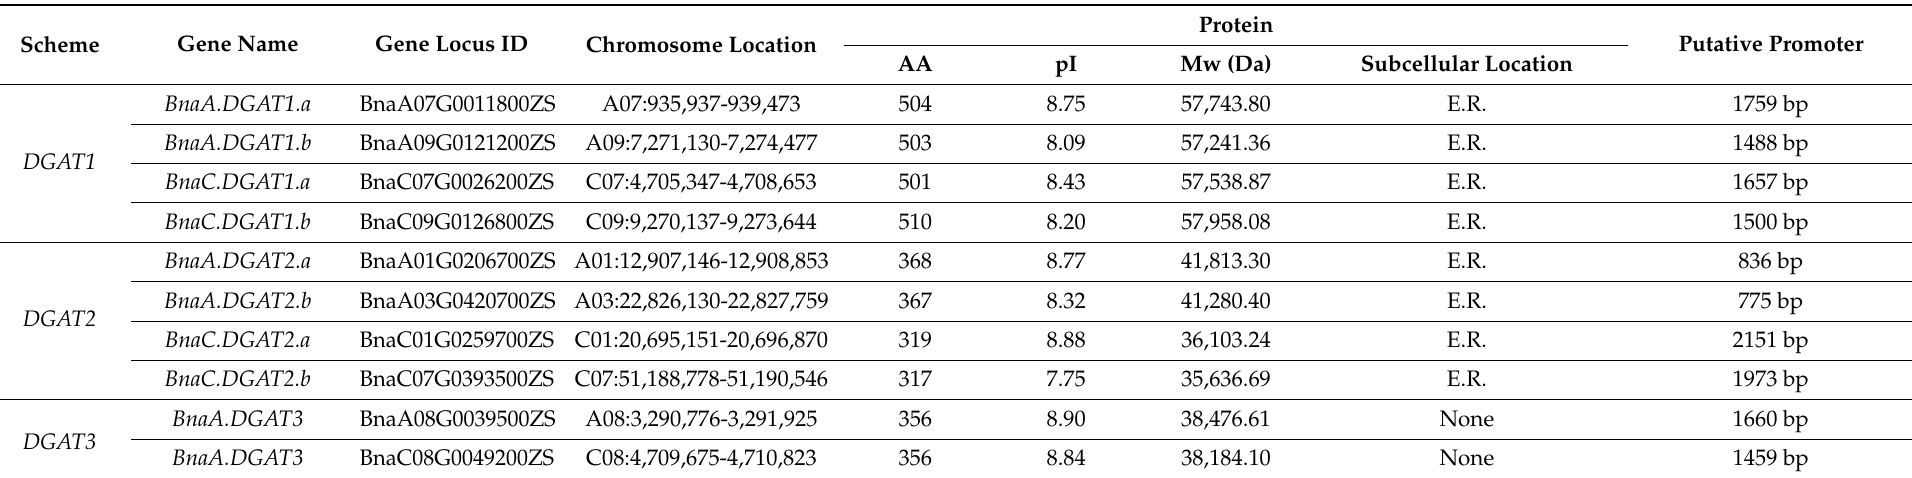
Table 2. Cloning and characterization of the members of BnaDGAT